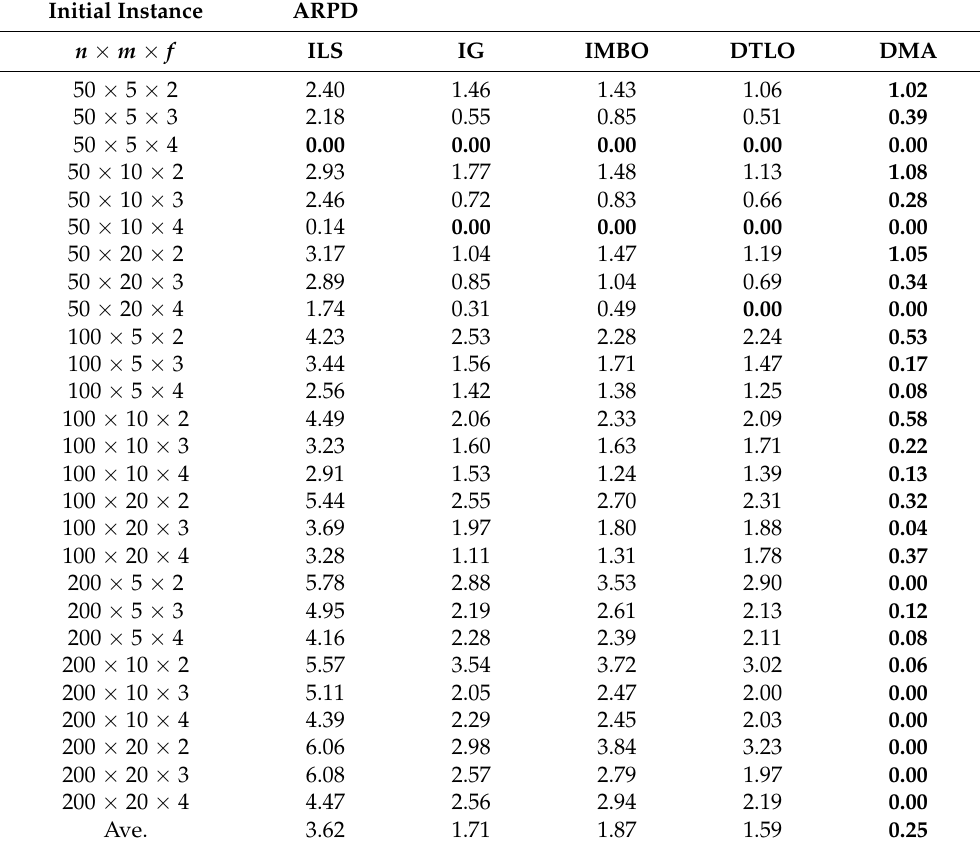
Table 4. Comparison results of different algorithms by β =